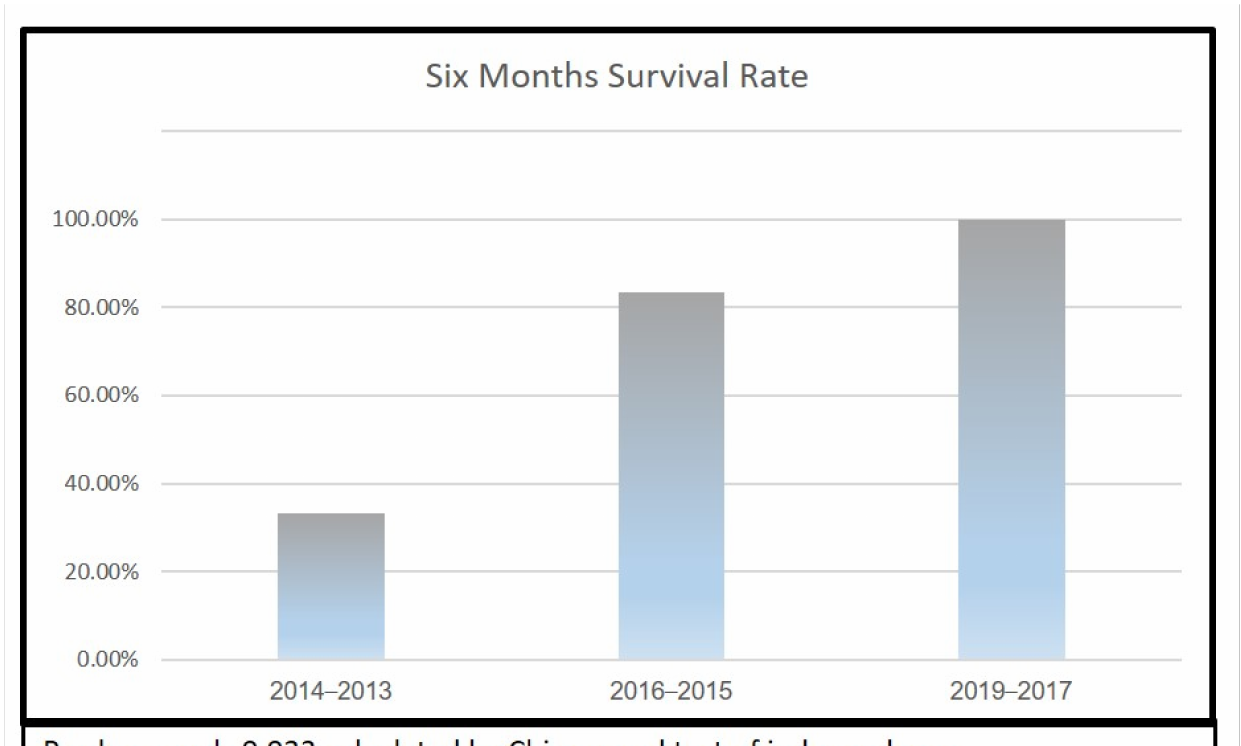
Figure 2. Six-month survival rate histogram for 19 patients with epidural spinal tumors operated by